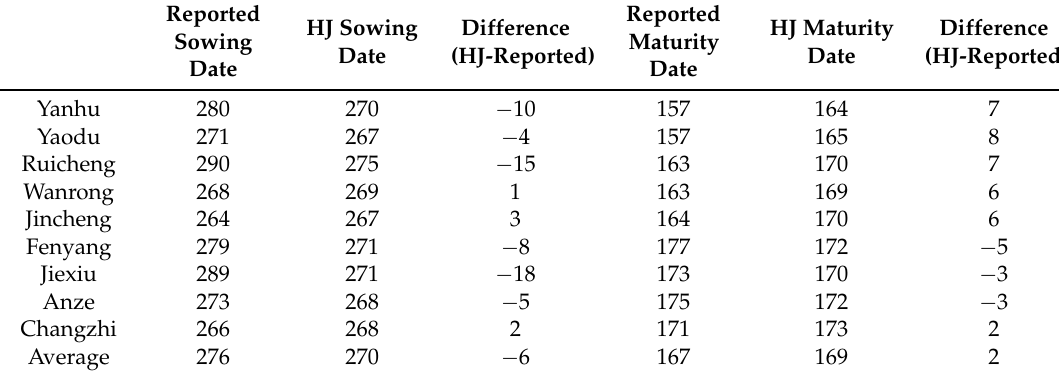
Table 3. Comparison of sowing and maturity dates (DOY) estimated with HJ-1A/B satellite and ground-based